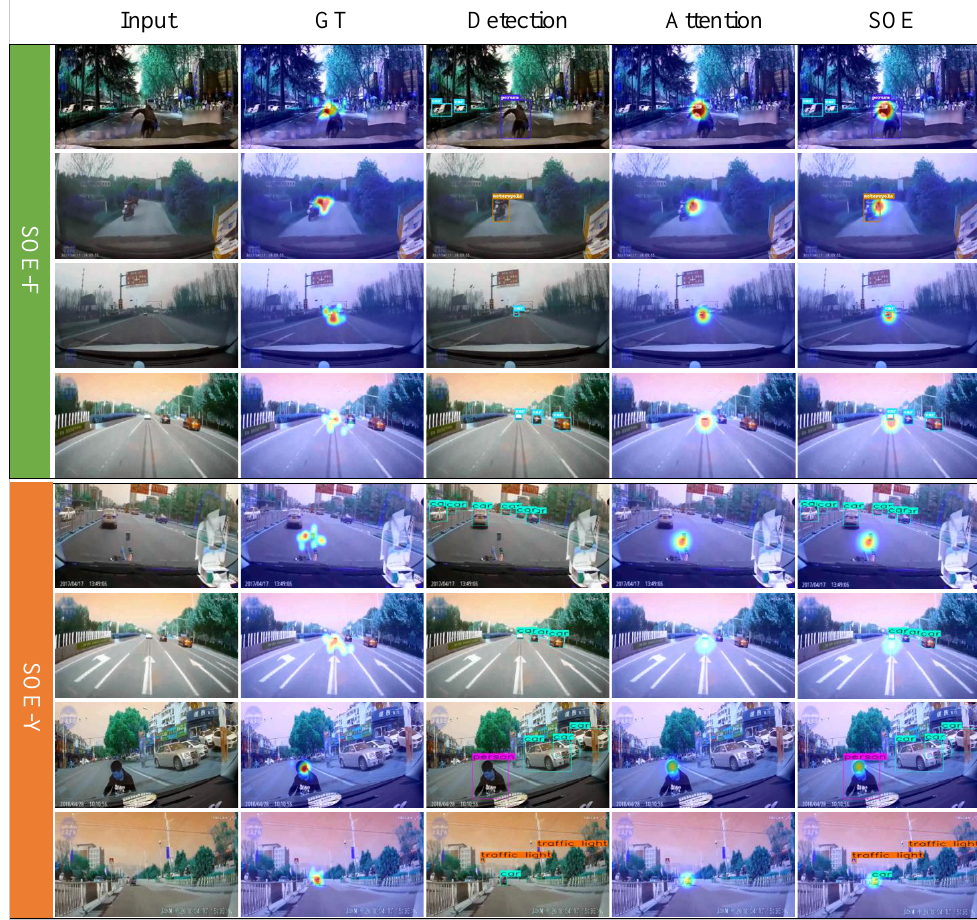
Figure 7. Visualization of the SOE-F and SOE-Y prediction results on the DADA-2000 dataset. The first four rows are from SOE-F and the last four rows are from